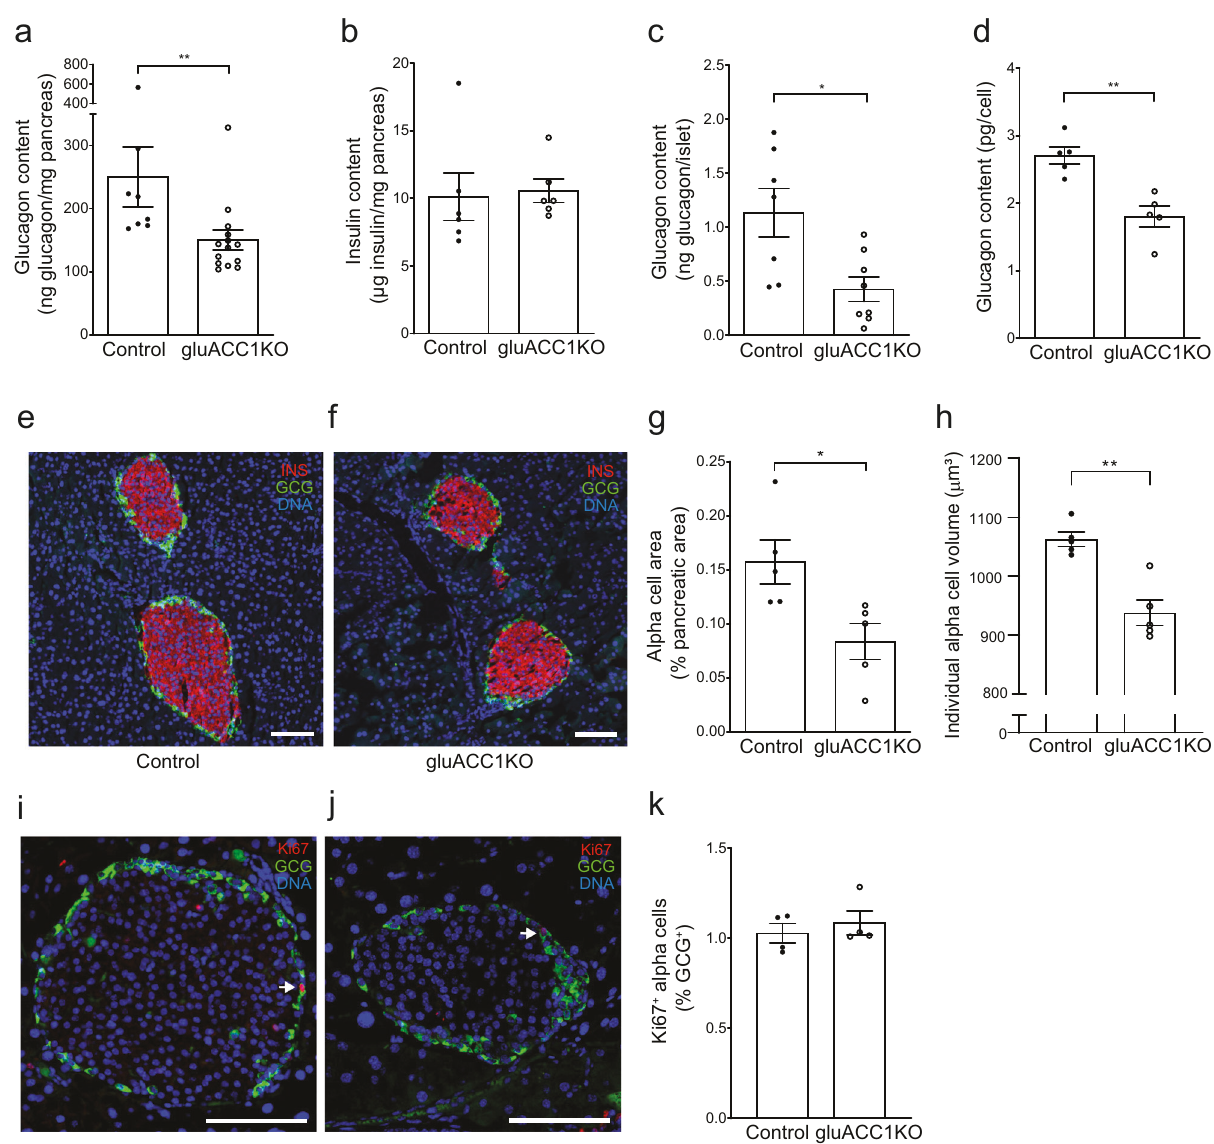
Fig. 6 Reduced glucagon content and alpha-cell size in gluACC1KO mice. a Pancreatic glucagon content was measured in control (black circles) and gluACC1KO (white circles) adult mice and normalised to pancreatic weight. Data from n = 8 – 14 mice. b Pancreatic insulin content measured as in ( a ); n = 6 mice. c Islet glucagon content measured in batches of 10 size-matched islets, isolated from n = 7 – 8 mice. d Glucagon content per cell quanti fi ed following fl uorescent-activated cell sorting of alpha-cells (Supplementary Fig. 1); n = 5 mice. e – h Formalin- fi xed paraf fi n-embedded pancreata from female mice were sectioned and stained for glucagon, insulin and DAPI before imaging and morphometric analysis using Halo software. e , f Representative images of pancreatic sections; glucagon (green), insulin (red) and DAPI (blue); scale bar 100 microns. g Alpha-cell proportional area: percentage of two- dimensional pancreatic area stained positive for glucagon; n = 5 mice. h Mean individual alpha-cell volume calculated by dividing the glucagon positive area by the number of nuclei in that area and extrapolating to three dimensions; n = 5 mice. i – k Quanti fi cation of proliferating alpha cells. Formalin- fi xed paraf fi n-embedded pancreata from female mice were sectioned and stained for glucagon, Ki67 and DAPI before imaging and cell analysis using Halo software. i , j Representative images of pancreatic sections; glucagon (green), Ki67 (red) and DAPI (blue); scale bar 100 microns. k Quanti fi cation of glucagon positive, Kir67 positive cells expressed as a percentage of total glucagon positive cells. n = 5 mice. Data in a – d , g , h and k are presented as mean ± SEM and analysed by Mann – Whitney U test. Signi fi cance thresholds: * P < 0.05, ** P <